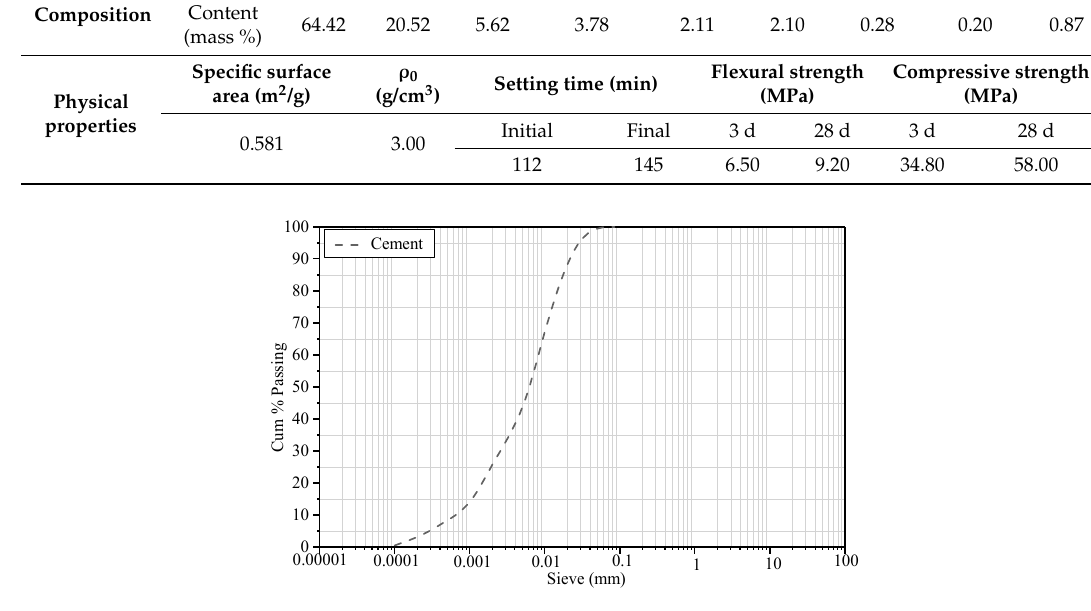
Figure 1. Particle size distribution of OPC. Table 2. Properties of graphite oxide. Table 1. Chemical composition and physical properties of OPC.